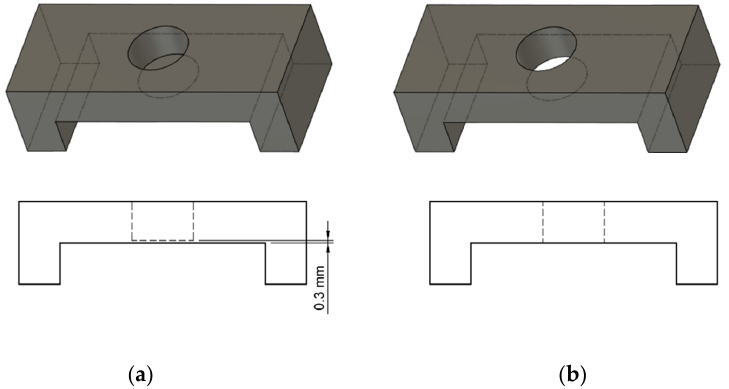
Figure 9. ( a ) Bridge feature with a closed hole, ( b ) bridge feature with hole.